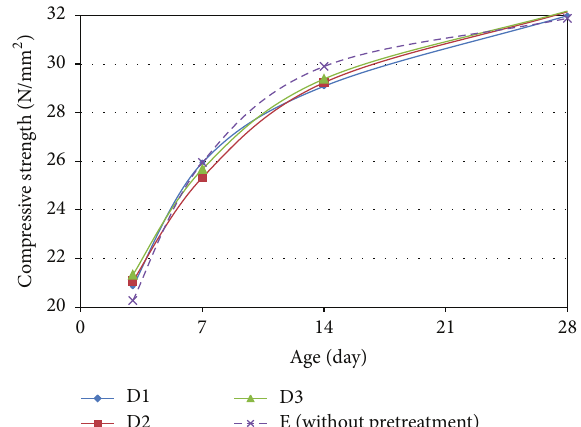
Figure 12: Development of compressive strength for the OPSGPC with PVA solution treated OPS in oven-cured condition.